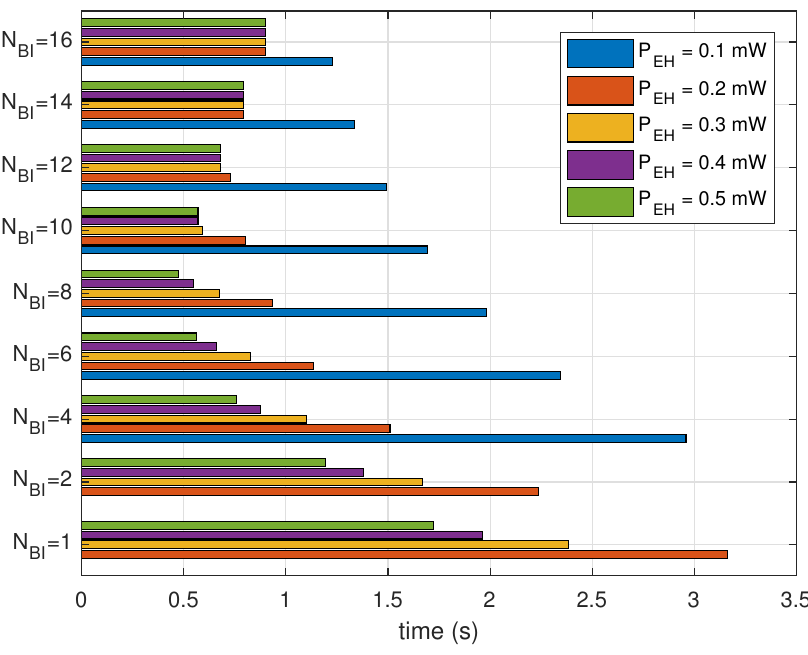
Figure 9. Average time spent to recognize one beacon.